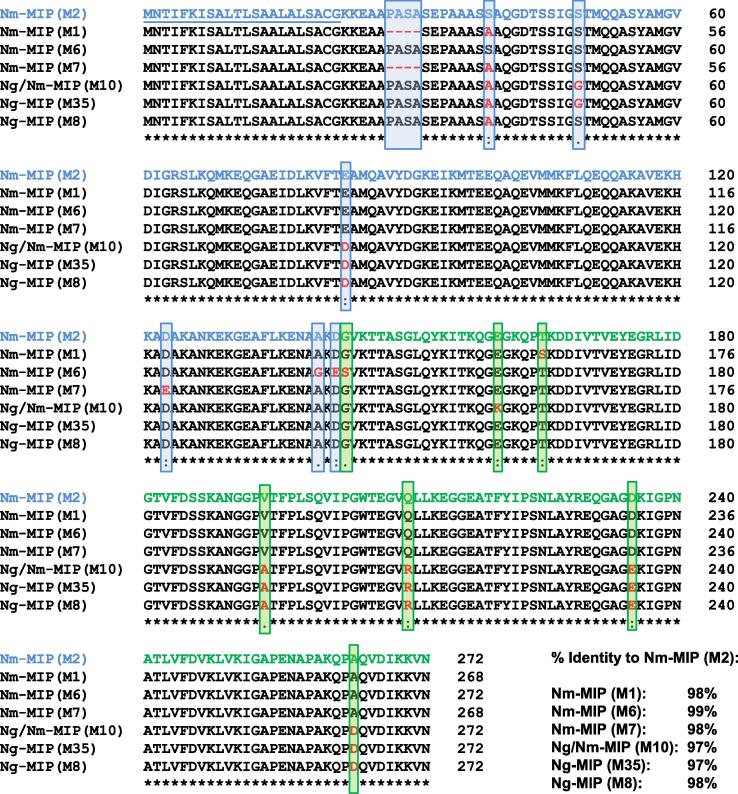
Clustal alignment of representative Nm-MIP and Ng-MIP proteins. Amino acid sequence alignment of Nm-MIP (M1, M2, M6, M7) and Allele 8, 10 and 35-encoded Ng-MIP proteins (M8, M10 and M35). The regions in Nm-MIP M2 (Type I) sequence highlighted in blue and green correspond to residues 1–142 (N-terminal domain) and 143–272 (C-terminal domain), respectively. The leader sequence in Nm-MIP M2 (Type I) (amino acids 1–22) is underlined. Distinct amino acid residues to Nm-MIP M2 (Type I) are highlighted in red and shown within a blue or a green box, depending on whether they belong to the N- or C-terminal domain. The percentage of identity of each protein to M2 (Type I) Nm-MIP is specified. (For interpretation of the references to colour in this figure legend, the reader is referred to the web version of this article.)